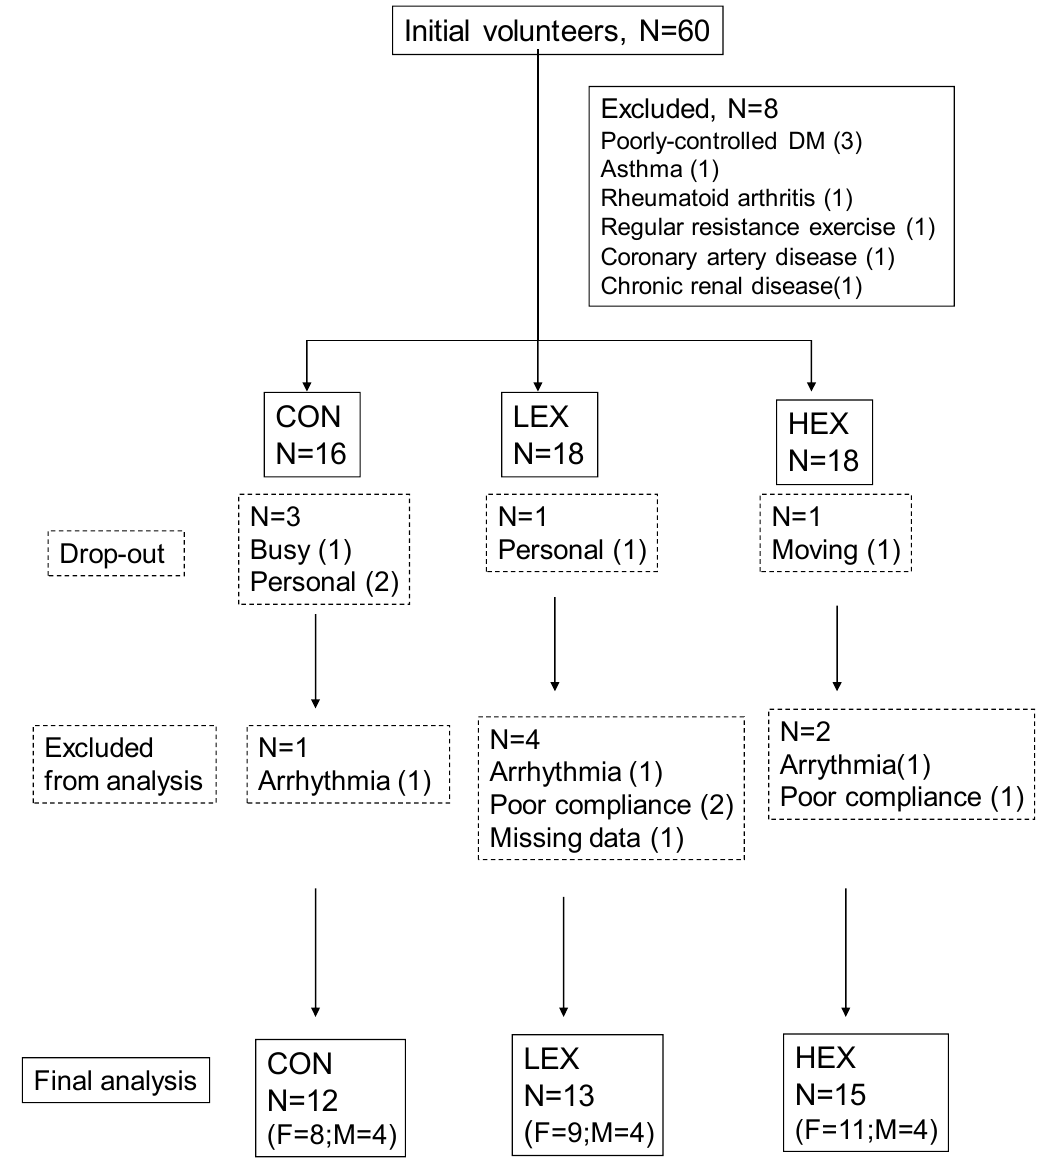
Figure 1. Flowchart of the study. F, female subjects; M, male subjects. CON, control group; LEX, low–middle-intensity training group; HEX, high-intensity training group.